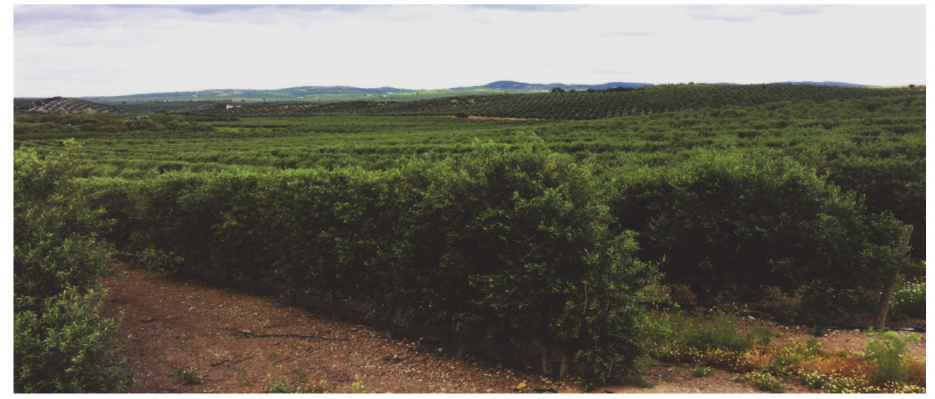
Figure 1. A super high-density hedgerow olive orchard located in C ó rdoba province